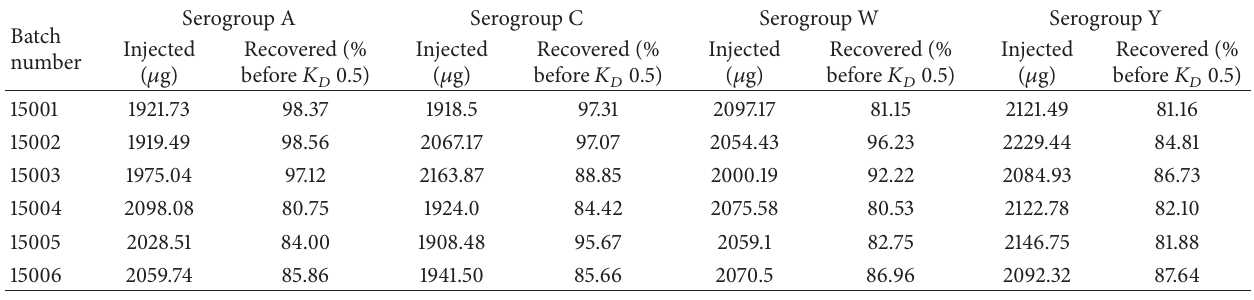
Table 2: The injected and recovered polysaccharide content of serogroups A, C, Y, and W of six batches of Ingovax ACWY vaccine. Batch